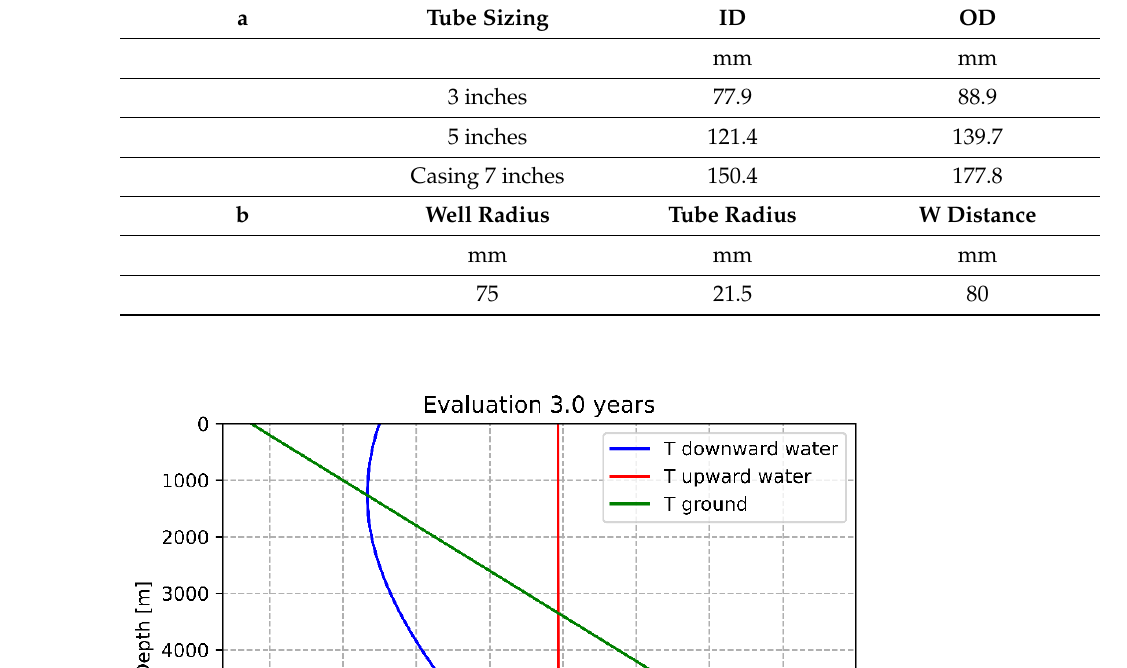
Table 4. ( a ). Coaxial WBHE tube sizing. ID: internal diameter; OD: external diameter [24]; ( b ). U-tube WBHE parameters [25].